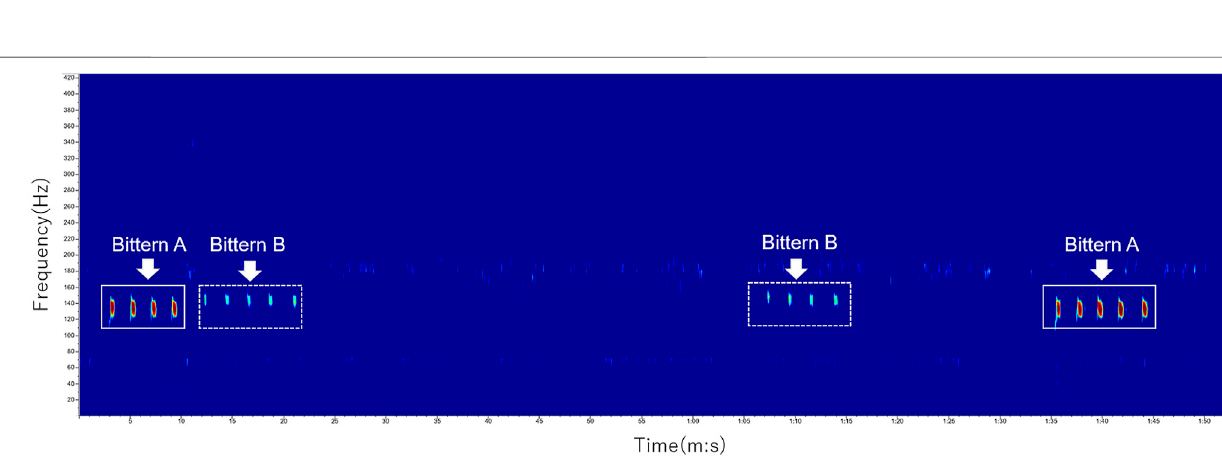
FIGURE 8 | Example spectrograms of the two bitterns ’